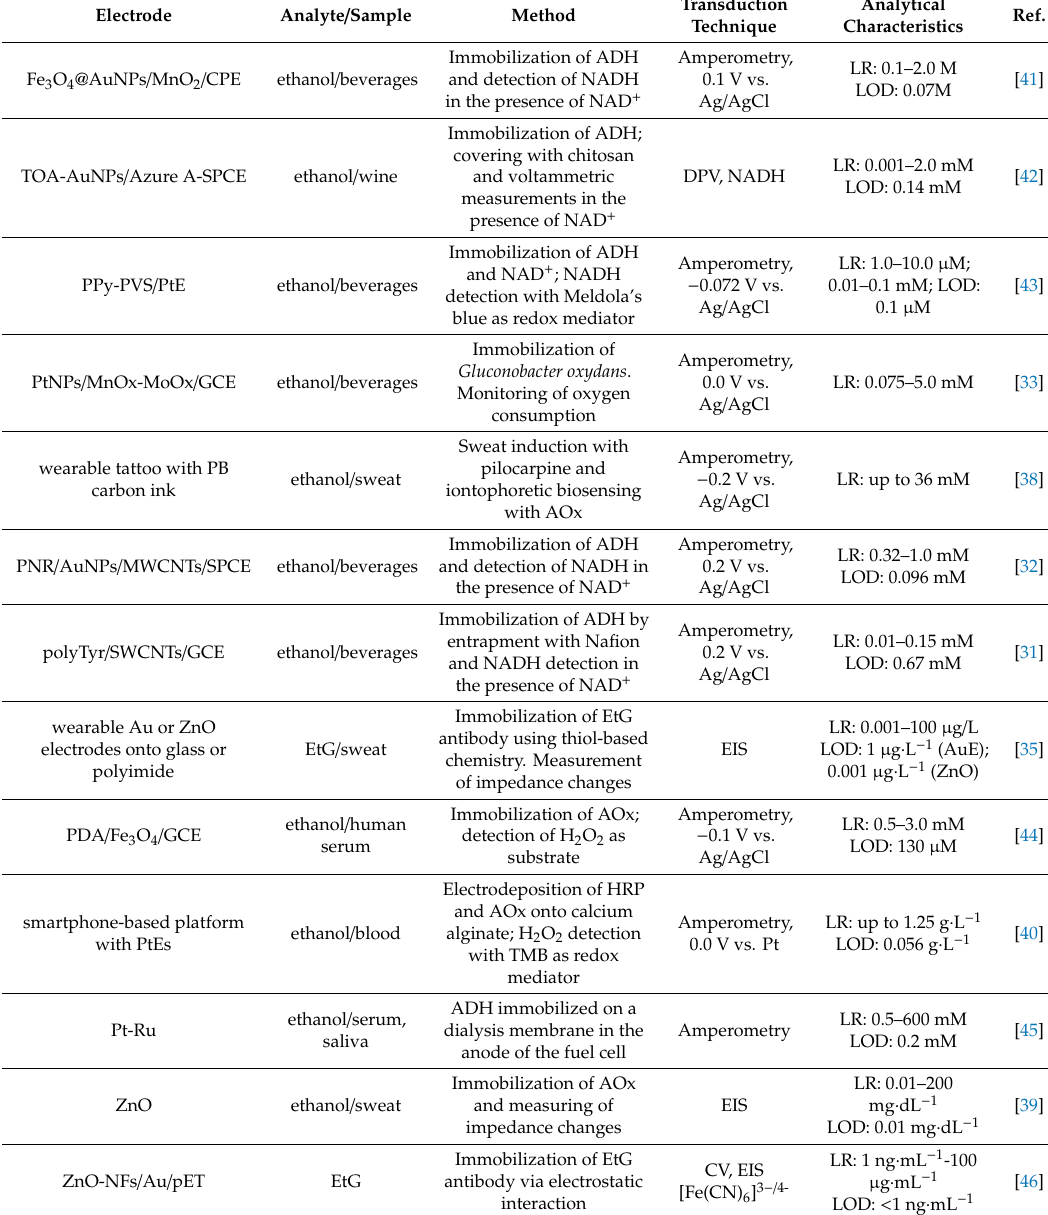
Table 2. Electrochemical biosensors for ethanol and ethanol metabolites.